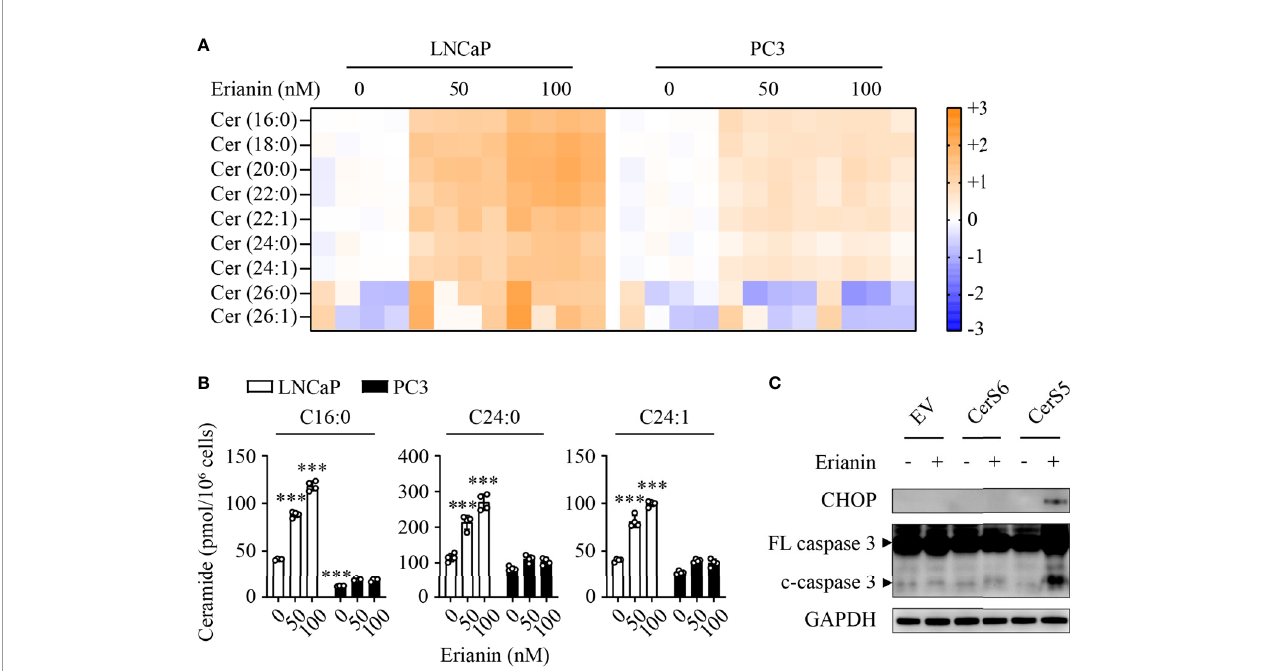
FIGURE 6 | C16 ceramide determines PCa cell response to erianin. (A, B) LNCaP and PC3 cells were treated with erianin at indicated concentrations for 24 h. Lipids were extracted and analyzed using targeted lipidomics. Lipid heatmap shows the changes in levels of ceramides (Cer), sphingosine (Sph) and sphingosine 1- phosphate (S1P). The color key indicates the fold change on a log2 scale (A) . Absolute levels of C16:0, C24:0 and C24:1 ceramides (B) . Data are expressed as mean ± SD. n=4. ***, p <0.001, versus untreated LNCaP cells. (C) PC3 cells were transfected with empty vector (EV), ceramide synthase 5 (CerS5) and CerS6 for 48 h, prior to the treatment with erianin at 100 nM for an additional 24 h. CHOP and cleaved caspase-3 were examined by Western